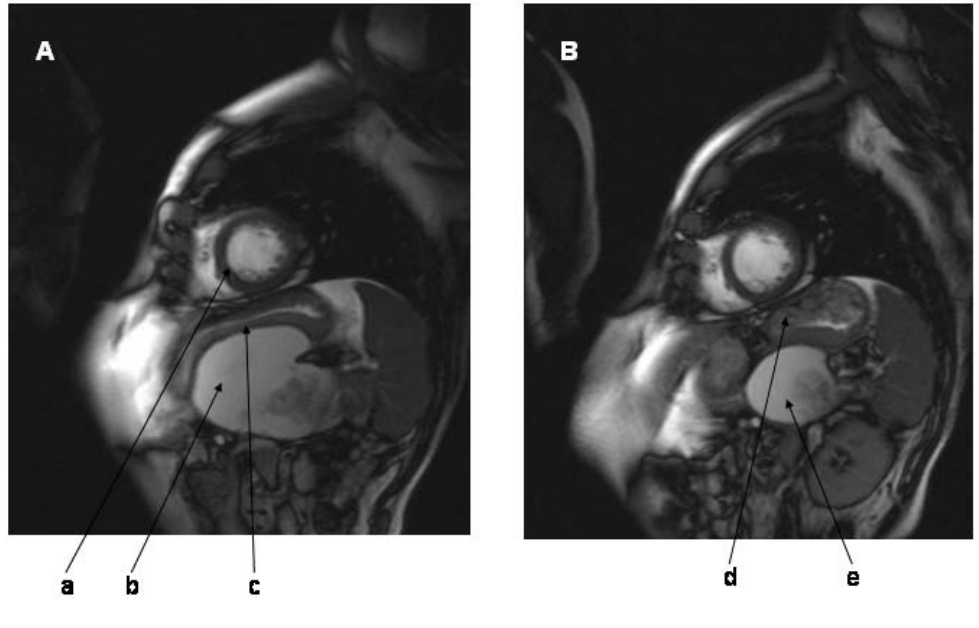
Figure 1A. Short-axis retro cine image through the mid-left ventricular cavity (a). A large pseudocyst (b) is seen within the lesser peritoneal sac, compressing the empty stomach (c). Figure 1B. The same MRI slice taken after three months of conservative treatment shows a significant reduction in the size of the pseudocyst (e). More space is afforded for gastric expansion as demonstrated by visible food contents within the stomach